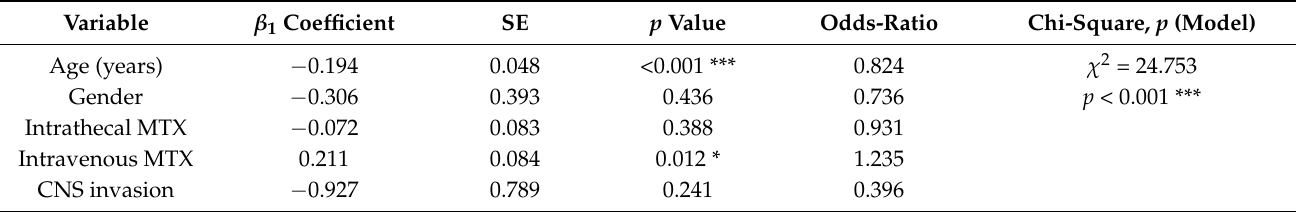
Table 2. Logistic regression analysis of effects of age, gender, treatment intensity, and CNS invasion on lesion prevalence.